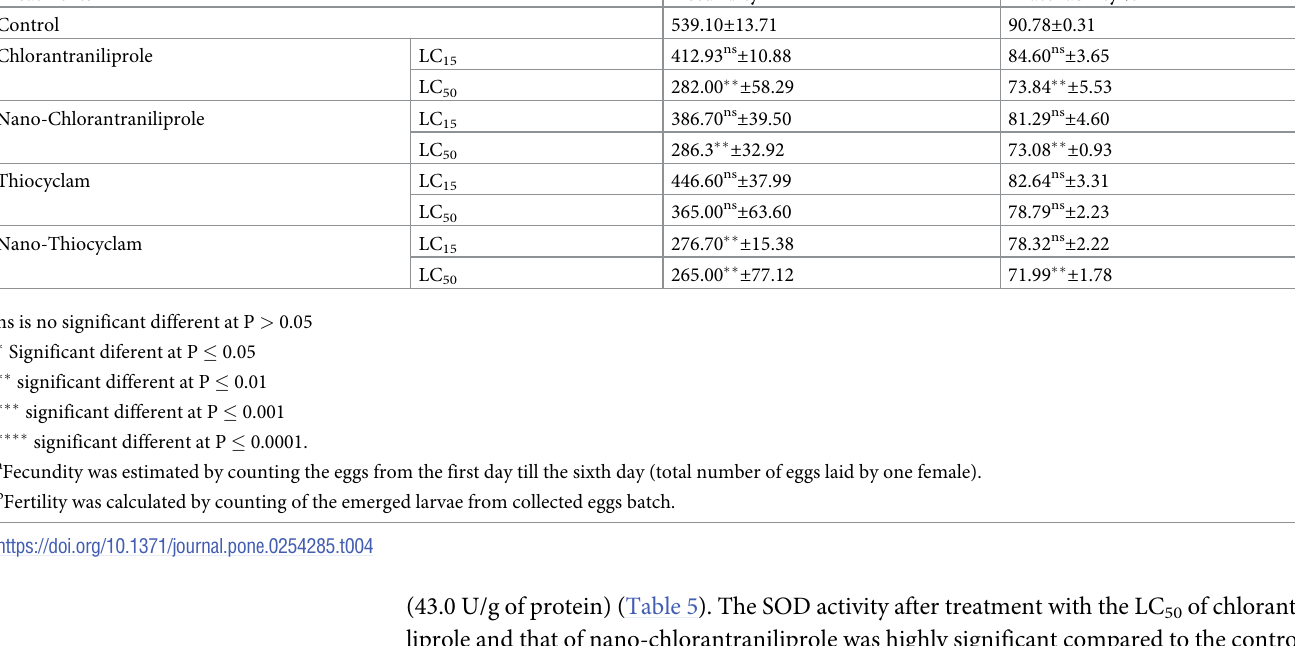
(43.0 U/g of protein) (Table 5). The SOD activity after treatment with the LC liprole and that of nano-chlorantraniliprole was highly significant compared to the control treatment with 45.38 and 53.96 U/g of protein (ca. 5.44, and 6.47 fold), respectively. No signifi- cant changes relative to the control were recorded in any other treatments. The LC and LC of both insecticides and their nano-forms stimulated CAT activity com- 15 50 pared to the control (Table 5). A significant increase in CAT activity was observed at the LC of chlorantraniliprole and nano-chlorantraniliprole, the LC LC and LC of nano-thiocyclam (80.22, 87.76, 76.03, 80.28 and 86.43 U/mg of protein, 15, 50